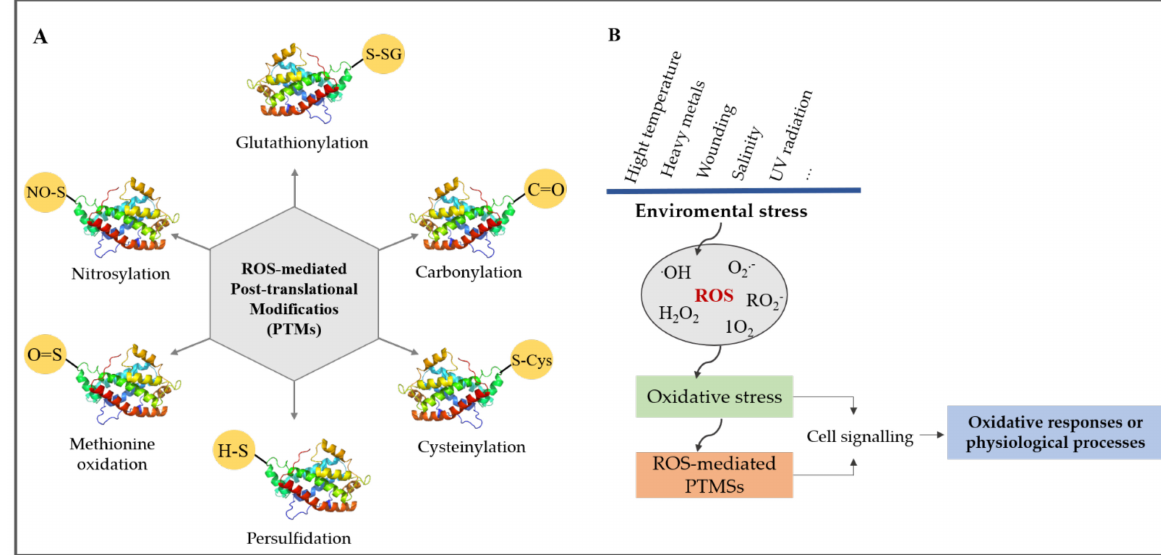
Figure 2. Overview of ROS-mediated post-translational modifications. ( A ) Most common ROS-mediated PTMs. The thiol groups of Cys and Met are prominently modified by ROS. The modifications include nitrosylation, cysteinylation, glutathionylation, methionine oxidation, persulfidation, and protein carbonylation. ( B ) Framework model of ROS-mediated PTMs in cell signaling in response to environmental stress in